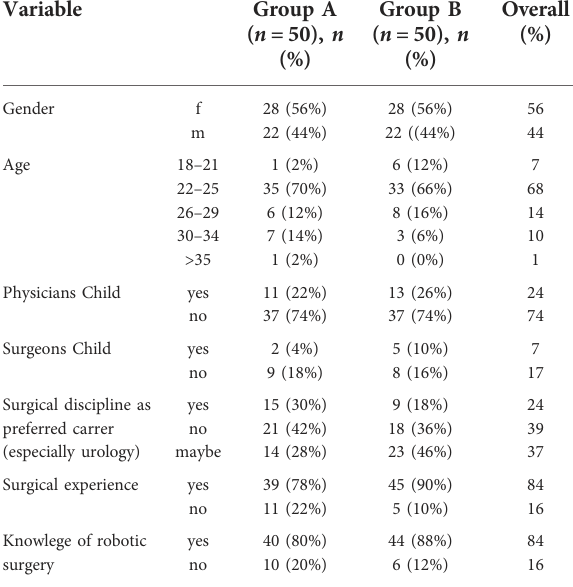
TABLE 1 Demographic characteristics of all 100 participating students. TABLE 2 Group B: Do you want to work in a surgical fi eld (especially urology)? ( p